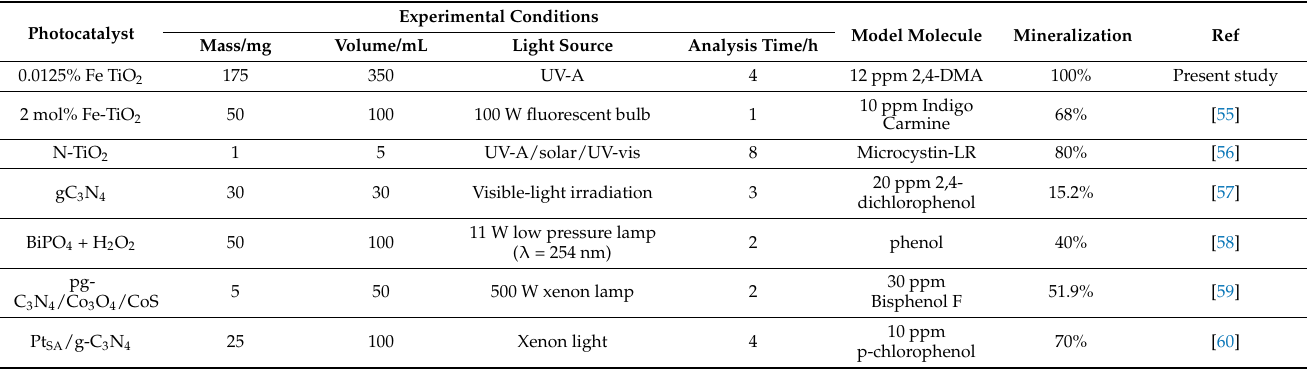
Table 5. Comparison of N-TiO 2 and Fe-TiO 2 photocatalysts with others.